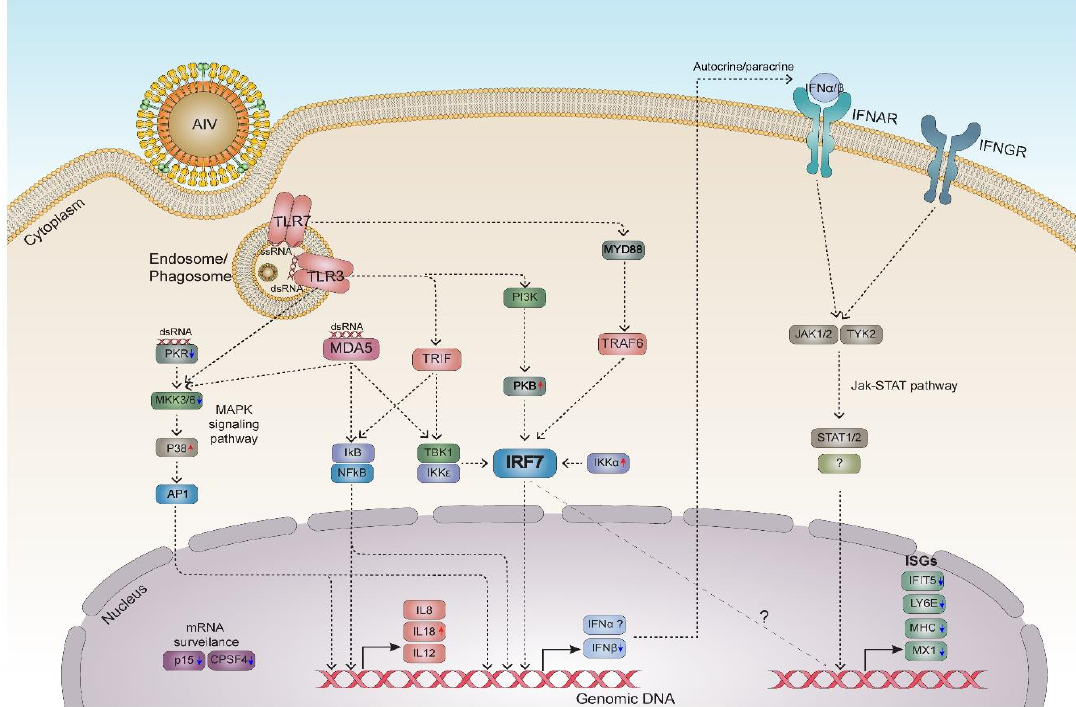
Figure 6. A proposed model of the molecular mechanism of chicken IRF7 modulation in the host response to avian influenza virus (AIV) infection A schematic model of the early antiviral response in chickens regarding IRF7 is proposed based on the DEGs in this study. AIV infection is sensed by pattern recognition receptors. TLR3 and TLR7 recognize endosomal/phagosomal double-stranded RNA (dsRNA) and single-stranded RNA (ssRNA) respectively. MDA5 and PKR respond to cytosolic dsRNA. This leads to a subsequent signaling cascade via adaptor molecules and protein kinases that activate the key transcription factors AP1, NF-κB and IRF7. The MAPK and PI3K/Akt pathways are potentially involved in the activation process. Activated IRF7 translocates to the nucleus and activates the transcription of IFNβ. AP1 and NF-κB also translocate to the nucleus and induce type I IFNs and inflammatory cytokines. Type I IFNs activate ISGs via the Jak–STAT pathway in an autocrine/paracrine manner through their receptors (IFNAR). IFIT5, interferon induced protein with tetratricopeptide repeats 5; JAK1/2, Janus kinase 1/2; LY6E, lymphocyte antigen 6 family member E; MKK3/6, MAPK kinase 3/6; MYD88, myeloid differentiation primary response 88; PKB, protein kinase B; STAT1/2, signal transducer and activator of transcription 1/2; TRAF6, TNF receptor associated factor 6; TRIF (TICAM1), toll like receptor adaptor molecule 1; TYK2, tyrosine kinase 2. Red and blue arrows indicate the up- and down-regulation of each gene respectively as a result of IRF7 knockout in the dataset. Further investigation is required for the items indicated by question marks.